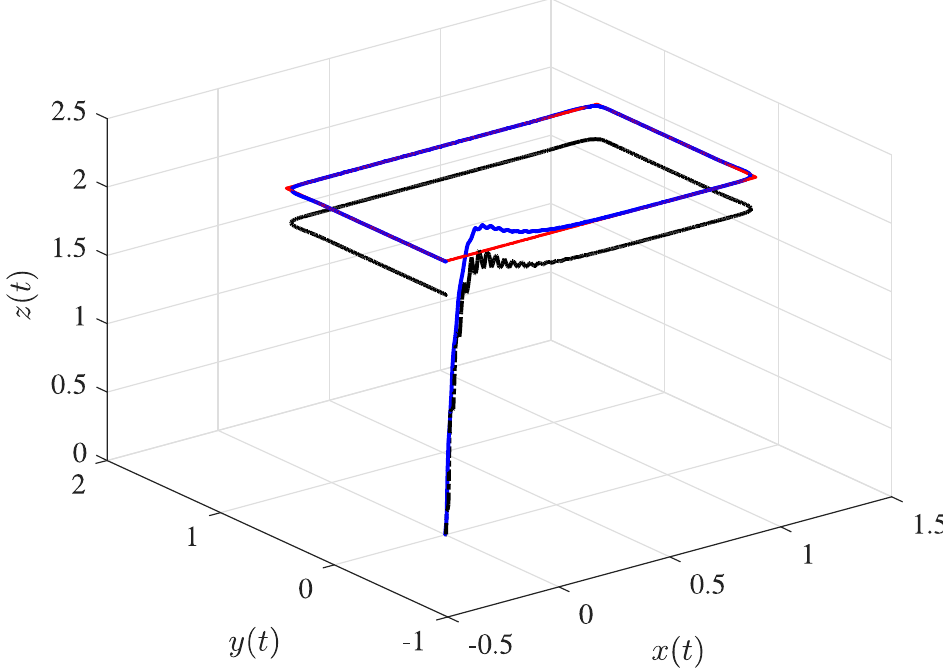
Figure 4. Three-dimensional trajectories of the quadrotor and its payload, showing the desired trajectory (solid red line), quadrotor trajectory (solid blue line), and payload displacement (dashed black line).